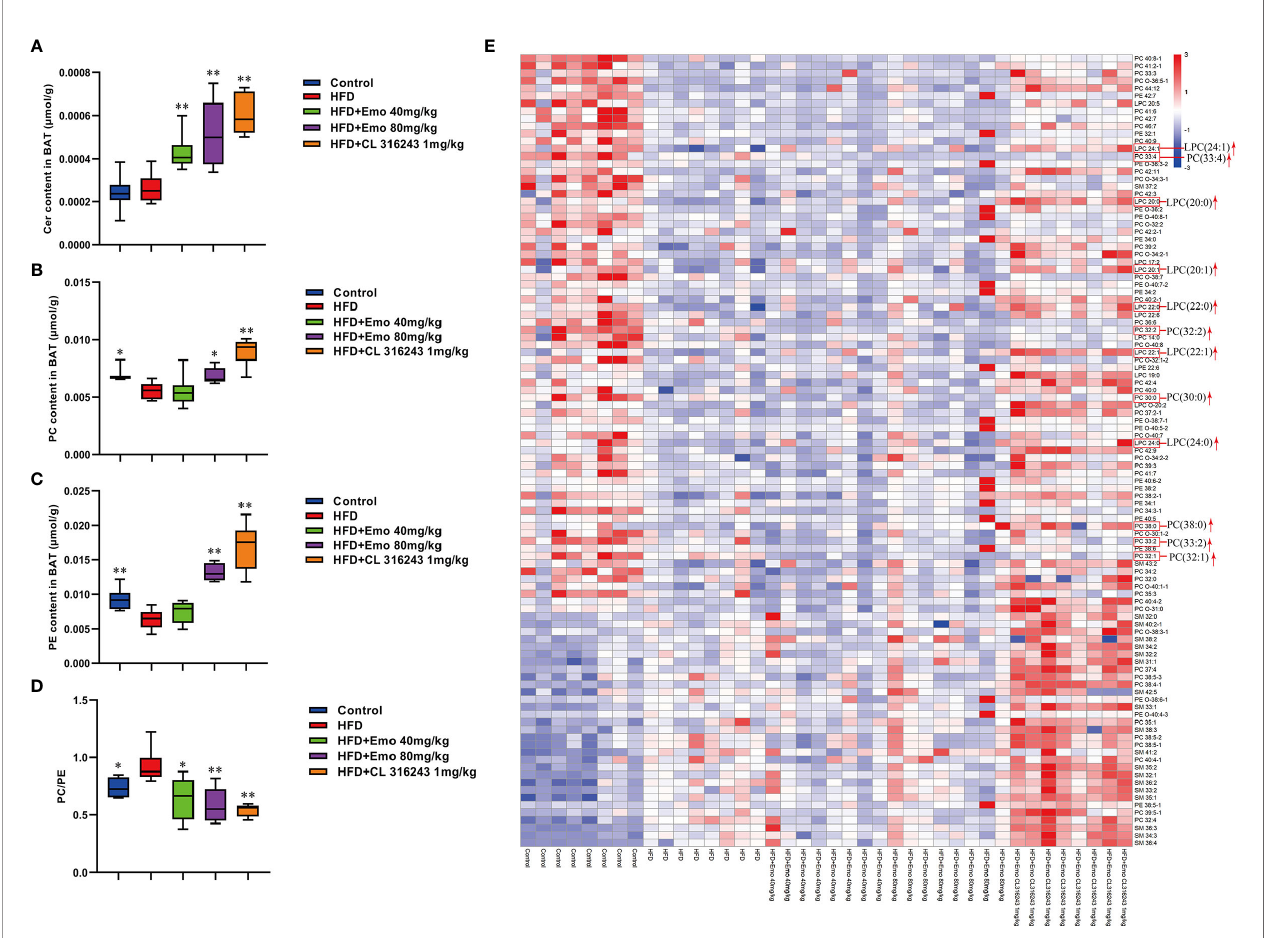
FIGURE 6 | Effects of emodin on the lipid metabolites in BAT of HFD mice. (A) The content of Cer in BAT. (B) The content of PC in BAT. (C) The content of PE in BAT. (D) The ratio of PC : PE in BAT. (E) Heat map. Only metabolites with VIP >1 and P < 0.05 were selected in heat map, and different shades of color present the concentration (red, white and blue presented the high, normal and low concentration). The red up arrow indicates up regulation or promotion. HFD, high fat diet; Emo, emodin; PC, Phosphatidylcholine; PE, phosphatidylethanolamine; Cer, ceramides. Data are expressed as mean ± SE. * P < 0.05, ** P < 0.01 vs. HFD